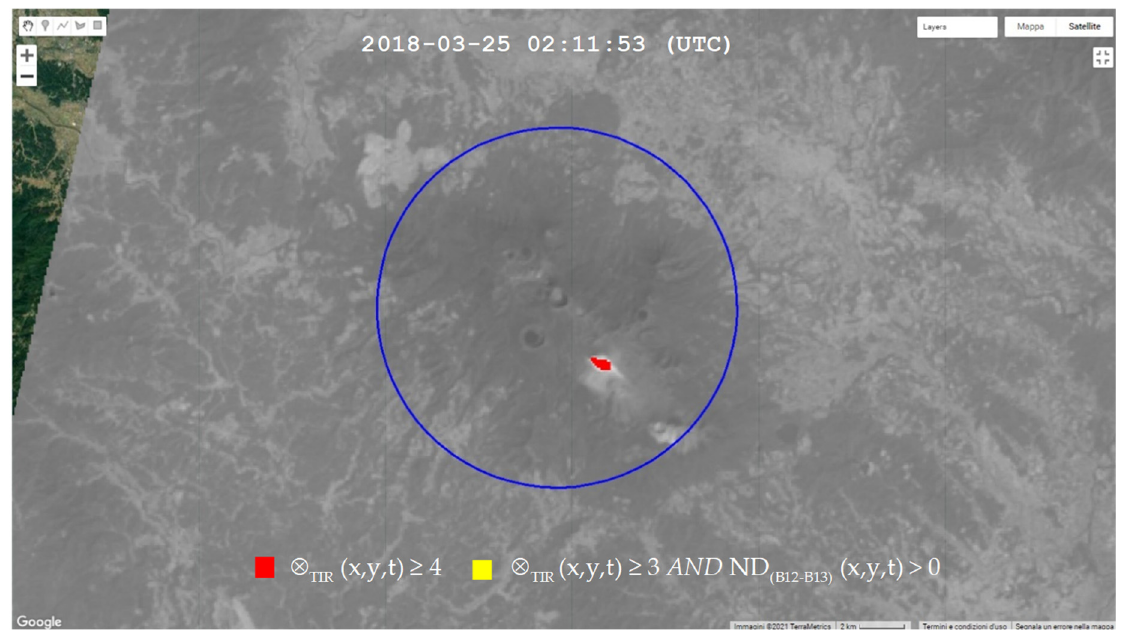
Figure 8. Thermal anomalies detected by RASTer at Shinmoedake volcano on 25 March 2018.